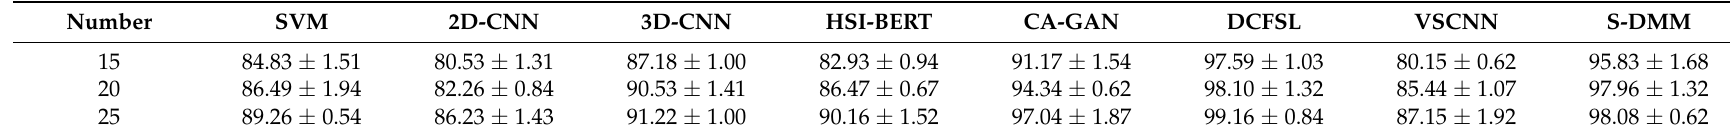
Table 10. The classification results of our proposed and other leading methods on the Kennedy Space Center dataset (%).